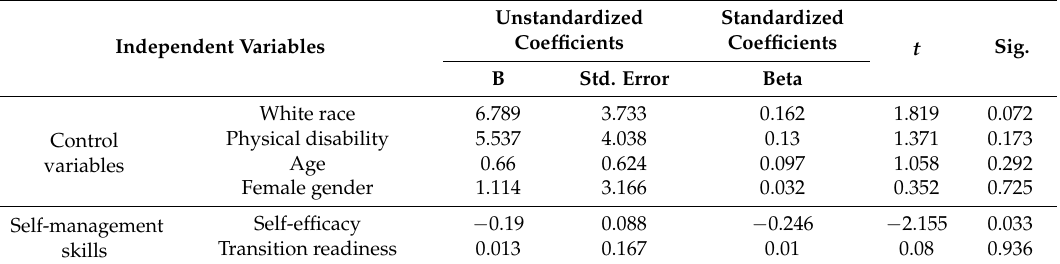
Table 4. Predicting caregiving burden by self-management skills (Model R 2 =